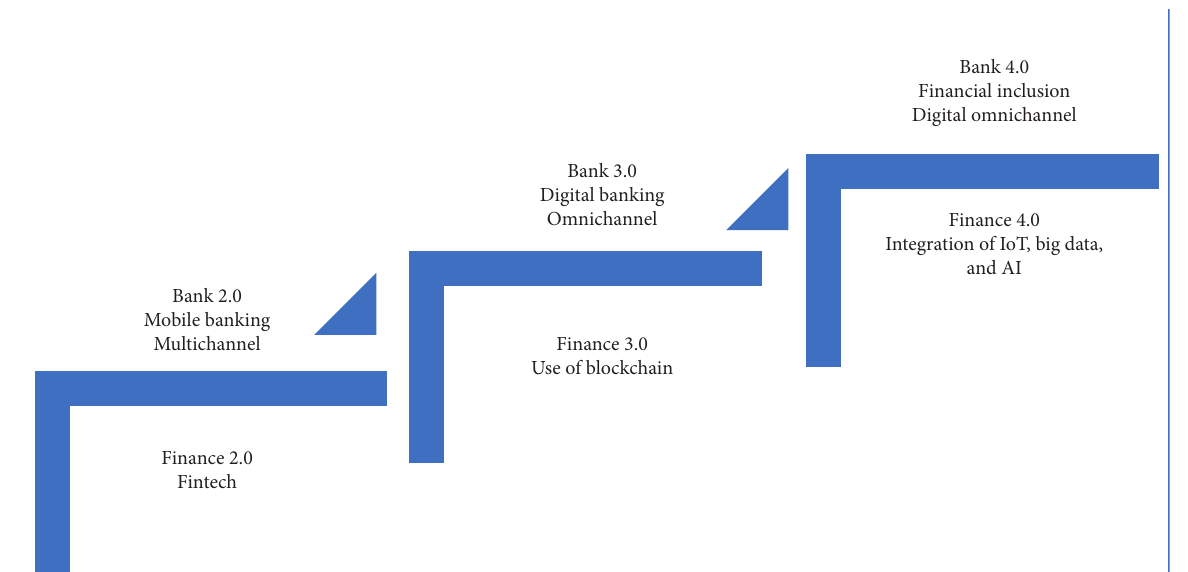
Figure 10: Generations of finance and banking systems.